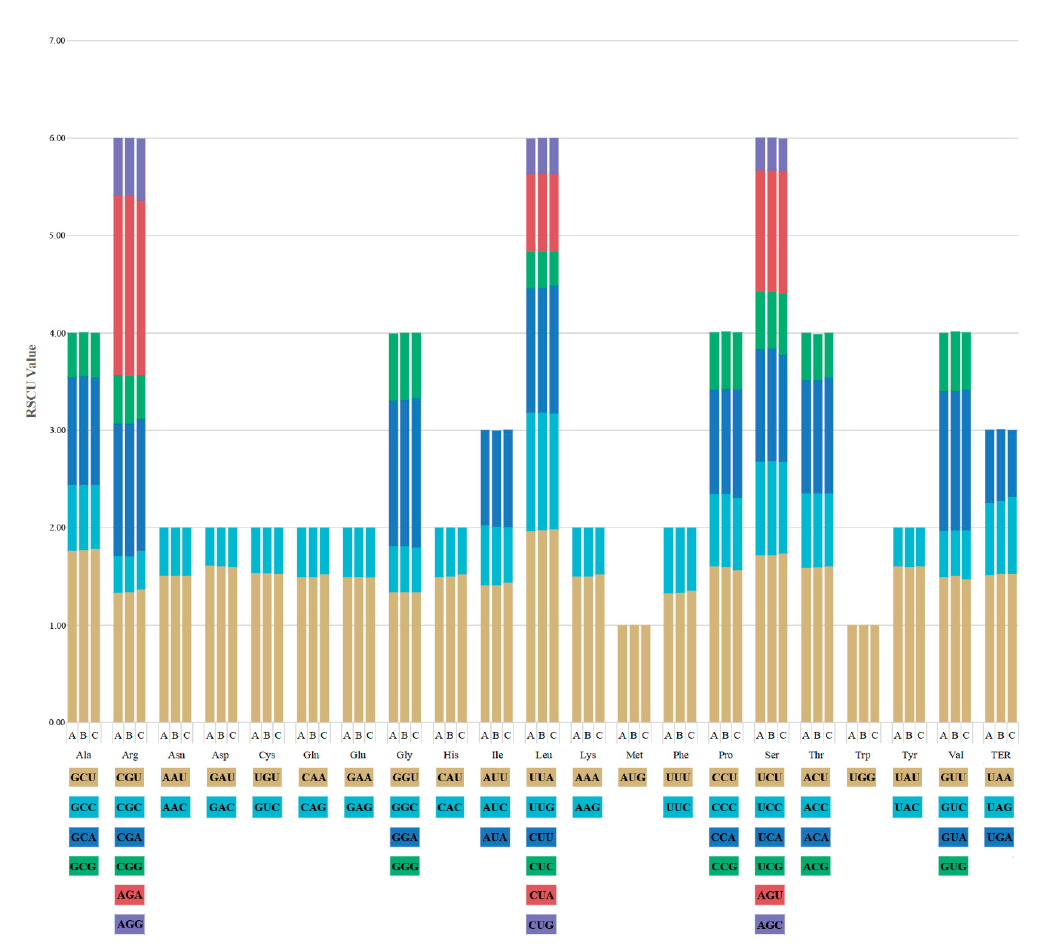
Figure 7. Codon content of 20 amino acids and the stop codon present in all 53 studied protein-coding genes (PCGs) of the ( A ) Hansenia , ( B ) Haplosphaera and ( C ) Sinodielsia plastid genome. Different colors of the histogram correspond to the different codons below.